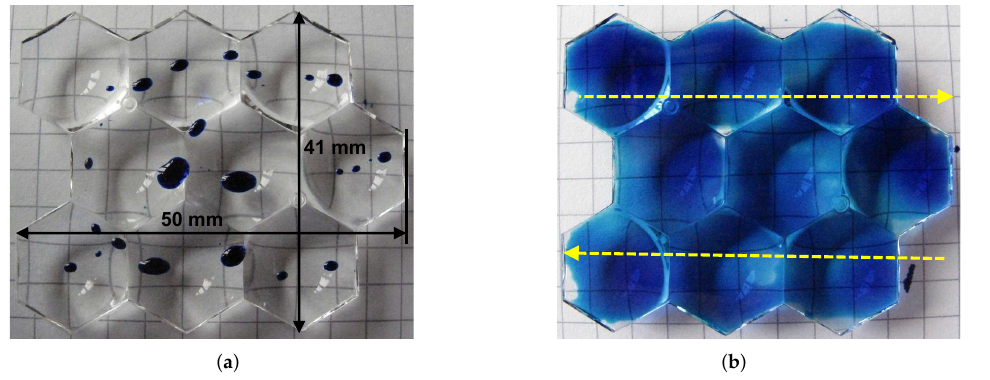
Figure 13. The wetting with formamide test ink (58 mN/m) of the PMMA lens panel ( a ) untreated, and ( b ) treated with nitrogen PDD. Treatment conditions: distance 6 mm, nitrogen flow: 8.0 SLM, relative PZ3-i movement as shown by yellow arrows, and movement speed: 20